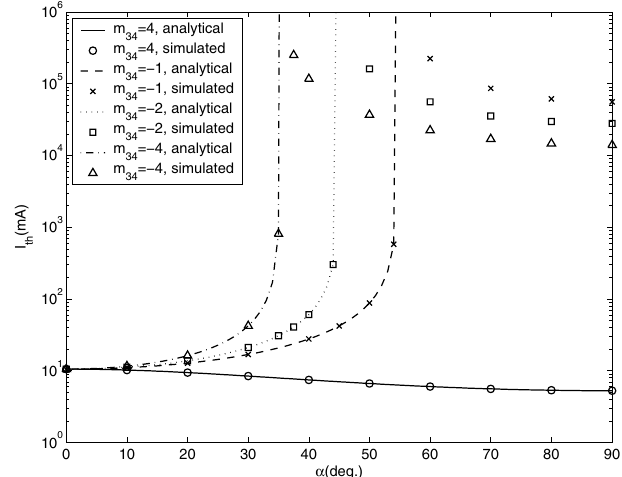
FIG. 1. BBU threshold for the recirculation matrix given by (26), calculated from (15) and simulated by the new code, vs (cid:6) < 0 , analytical and simu- HOM rotation angle. For m (cid:15) sin (cid:5) !T r 12 lation results practically coincide with each other. For (cid:6) > 0 , the simulation results show strong BBU sup- m (cid:15) sin (cid:5) !T r 12 pression instead of the infinite threshold predicted by